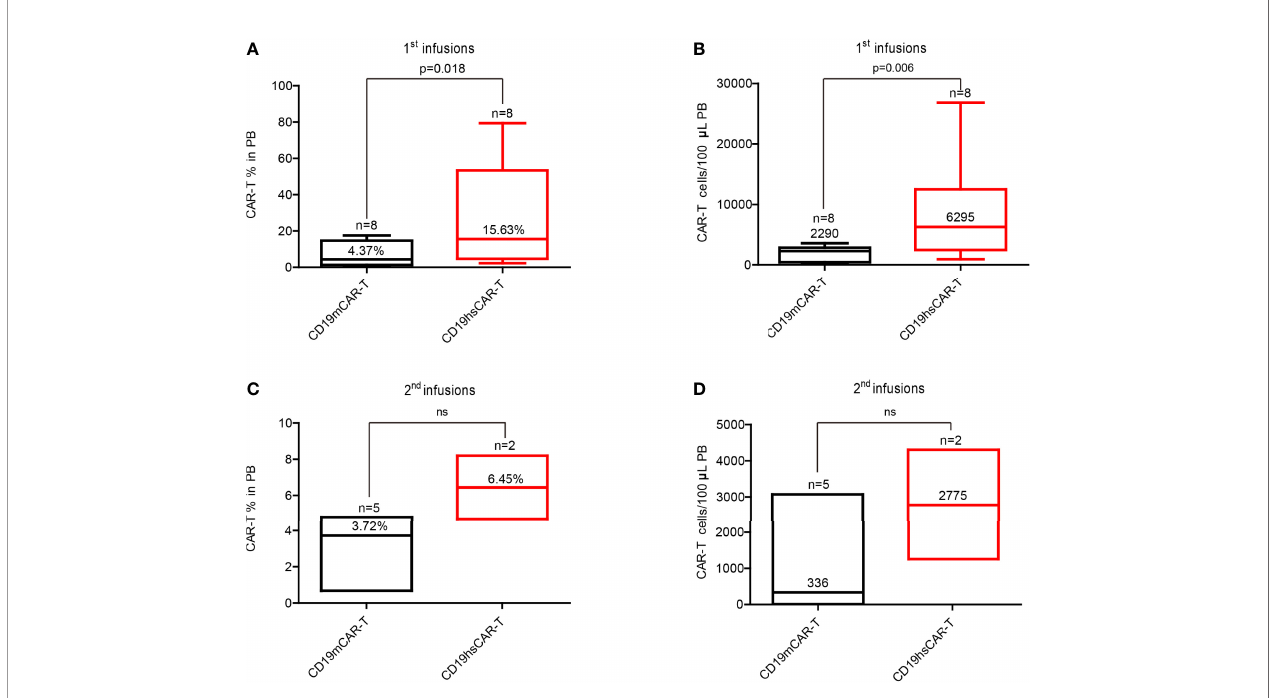
FIGURE 5 | Median of peak values of the CAR-T percentage and cell count in PB after infusion of CD19m CAR-T and CD19hs CAR-T, respectively. (A, B) Median of peak values of CAR-T percentage and cell count after the 1 st infusions of CD19m CAR-T (n = 8) and CD19hs CAR-T (n = 8). (C, D) Median of peak values of CAR-T percentage and cell count after the 2 nd infusions of CD19m CAR-T (n = 5) and CD19hs CAR-T (n = 2). Bars represented the range of the peak values within 30 days after infusions. The median values are shown as straight lines in each bar. P values were determined by T-test, and the signi fi cant levels were identi fi ed as p < = 0.05. Levels of each cytokine were repeatedly tested 7 times within 30 days after infusions. ns, Not statistically signi fi